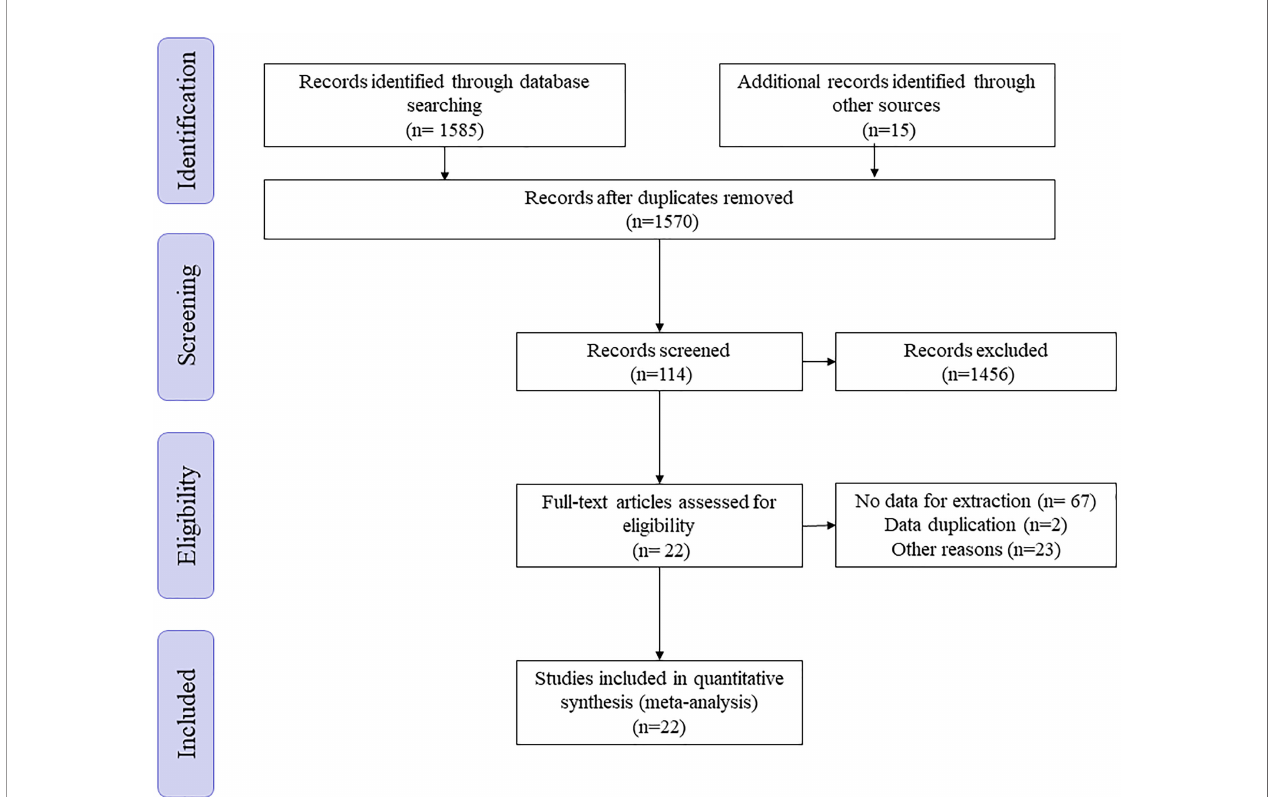
FIGURE 1 | The study selection